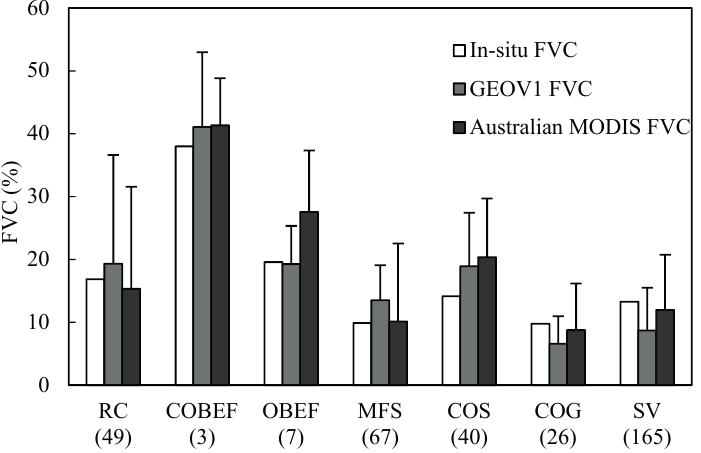
Figure 5. Comparison of GEOV1 and Australia FVC mean values with in-situ FVC for each biome types. Error bars represent +1 standard deviation. The number of in-situ observations for each biome is shown in the